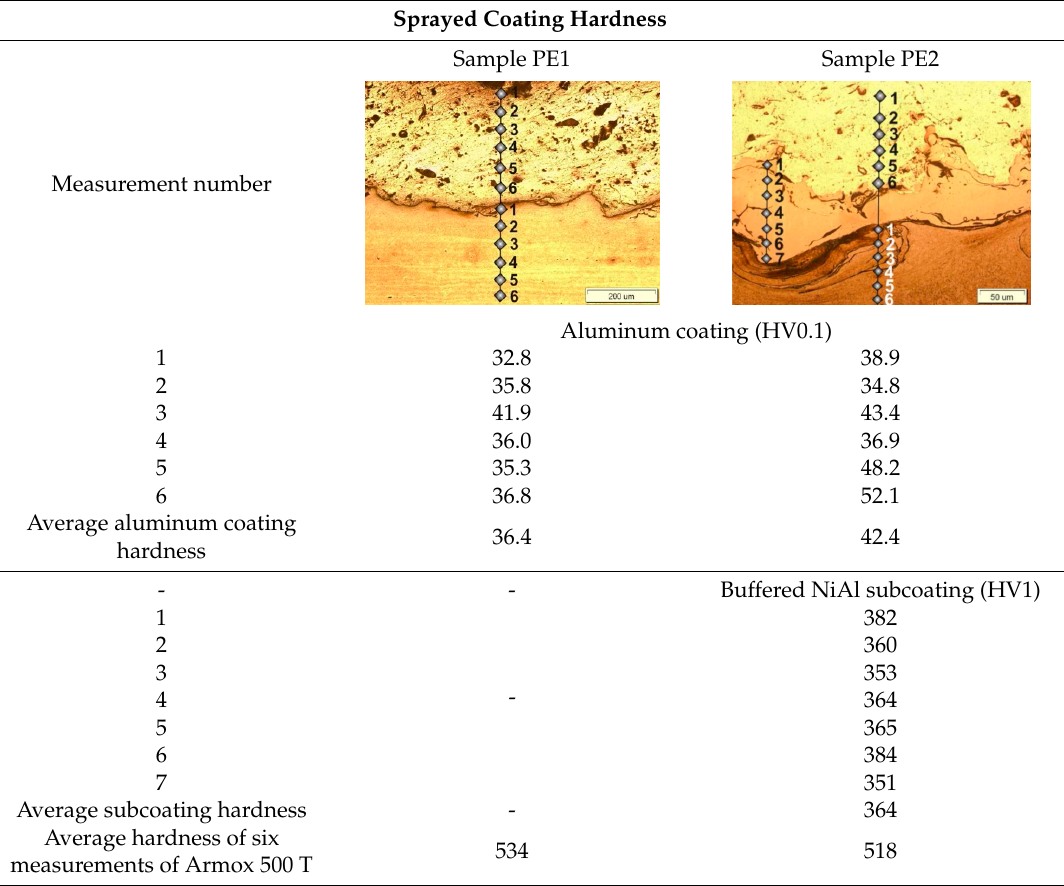
Table 6. Summary of results obtained during the static tensile test of arc sprayed coatings.